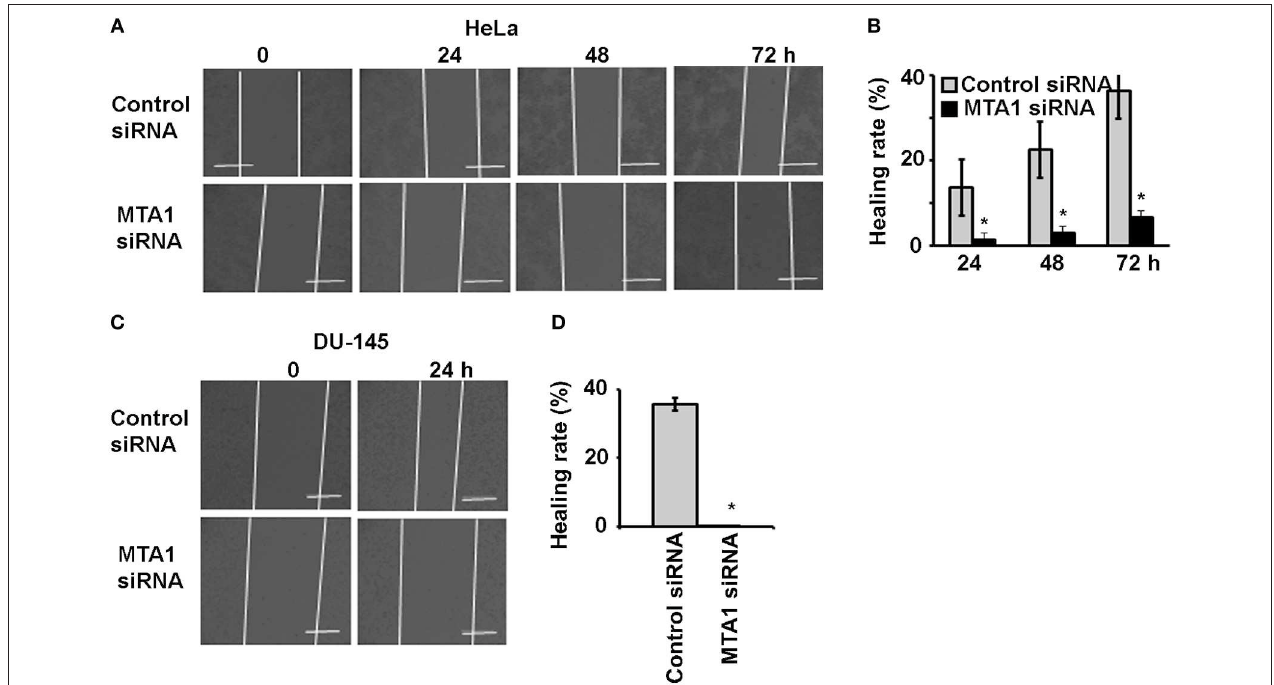
FIGURE 4 | IL-17A acts through MTA1 to promote migration of human cancer cells. HeLa and DU-145 cells were transfected with either control siRNA or siRNA targeting MTA1. Confluent monolayer of both control siRNA and MTA1 siRNA groups was scratched to make a wound and then treated with 20ng/ml recombinant human IL-17A for the indicated time points. (A,C) Representative photomicrographs of the wounds; dotted lines mark the front edges of migrating cells; scale bar, 400 µ m. (B,D) Wound healing rate was calculated as (wound width of time zero–that of each time point) ÷ wound width of time zero × 100%; data represent mean ± standard deviation (SD, error bars) of 3 independent experiments; * p < 0.05 between the MTA1 siRNA group and the control siRNA